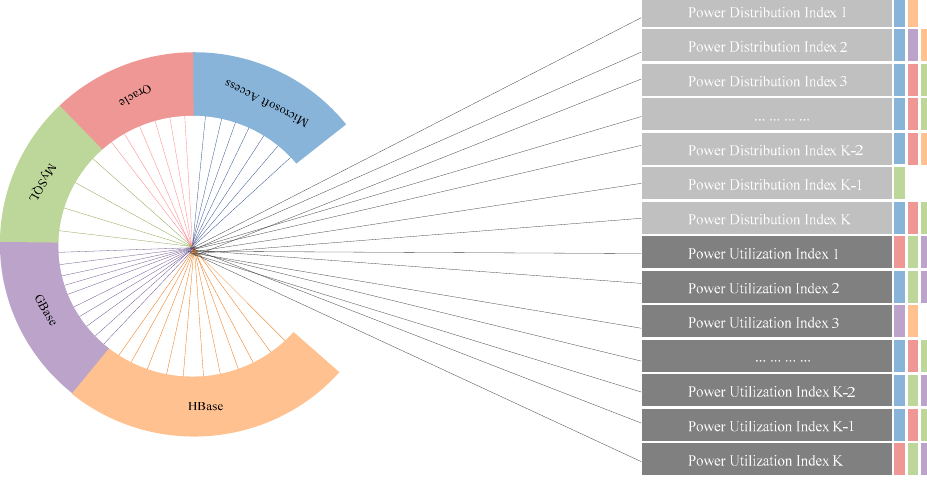
Figure 1. Multi-source heterogeneous big data system for intelligent power distribution and utilization (IPDU).